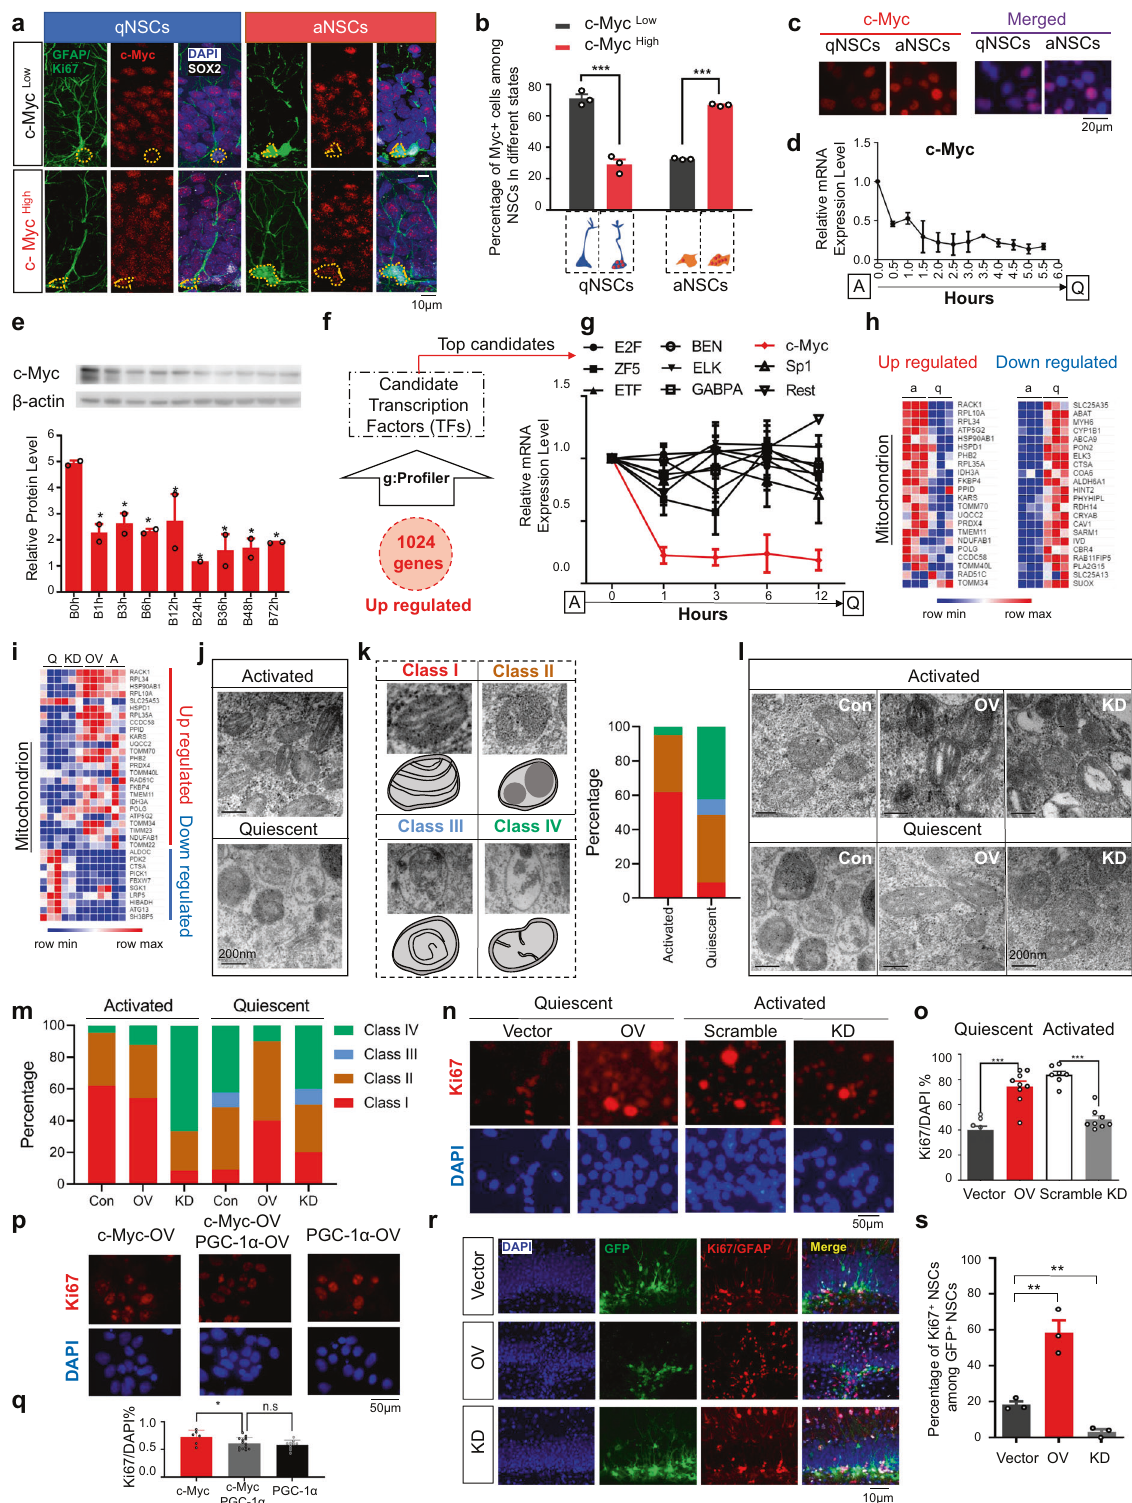
group (58% ± 10%; n = 3) and lower in the c-Myc KD group (3% ± 2%; n = 3) than in the control group (18% ± 3%; n = 3) (Fig. 1s). Their morphologies were drastically different too (Supplementary Fig. S6g). Essentially all c-Myc OV-GFP cells have lost RGL morphology and adopted aNSC/early progenitor morphology Signal Transduction and Targeted Therapy (2021)